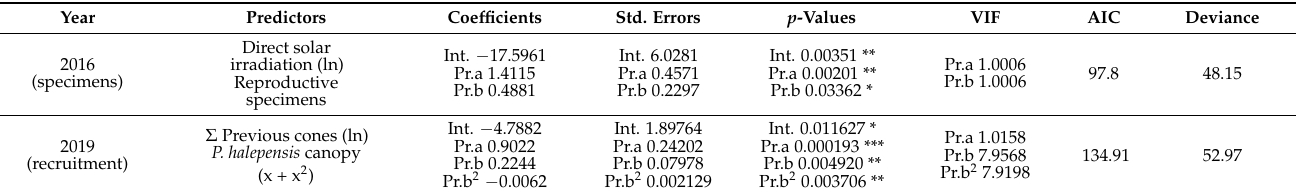
Table 7. Multiple regression negative binomial GLM models obtained for the total number of specimens (2016) and the observed recruitment (2019). Int.: intercept, Pr.a, b: predictor a or b, Pr. 2 : quadratic predictor. Significance codes: * < 0.05, ** < 0.01, *** < 0.001.